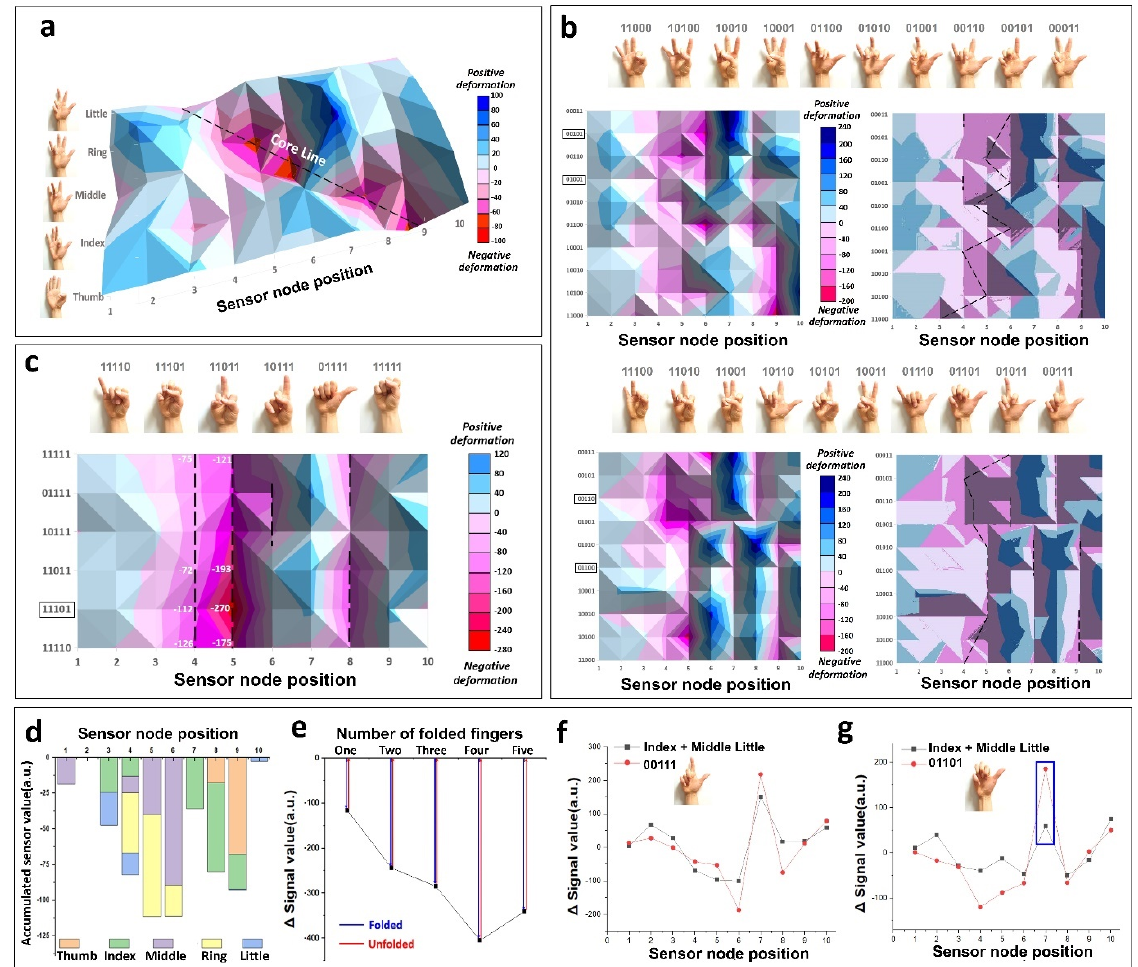
Figure 3. The core line analysis of skin deformation according to finger motion in dynamic mode. ( a ) Wrist skin deformation 3D color maps. A signal change due to the sensor node’s position is displayed according to individual finger movements. A negative deformation indicates the skin’s concave form, whereas a positive deformation indicates a convex shape. ( b ) Wrist skin deformation 3D color maps for a two-finger-fold ( top ) and a three-finger-fold ( bottom ). The signal characteristics were analyzed according to finger binary combinations based on vector quantization using K-means clustering. The left image is the original color, and the right figure is a vector quantized image. The black dotted line in the right color map indicates the core line. Image simplification was achieved by reducing image color type through color quantization. It was performed by taking the optimized K = 6 and K = 5 in two-finger-fold and three-finger-fold, respectively. The solid black box of the binary number represents that it is impossible to express actual gestures. ( c ) Colour map of wrist skin deformation for four or five finger-folds. ( d ) The accumulated signal value of individual fingers is in the negative range. ( e ) The correlation between the number of fingers folded and the signal change value. The blue line shows that the ADC signal decreases when the fingers are folded. On the other hand, the red line indicates the restoration to reference value when the fingers are unfolded. Furthermore, error bars according to the number of folded fingers are omitted because they are mixed statistics for various cases. ( f ) Correlation between finger multi-folding and individual folding. The additive signal value for individual fingers approximately coincides with the multi-folding signal. ( g ) The signal values between the individual finger sums and the multi-folding do not coincide. As shown in the solid blue square, the difference is at least